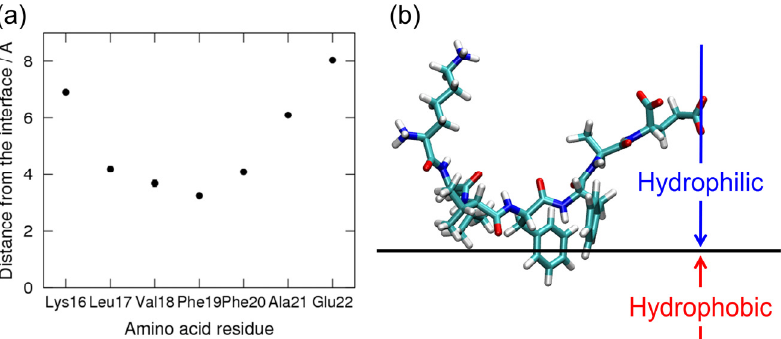
Figure 2. ( a ) Average distance of C α atoms from the interface. ( b ) A typical snapshot of an A β (16–22) monomer at the interface. Reprinted with permission from Reference [45]. Copyright 2020 American Institute of Physics.